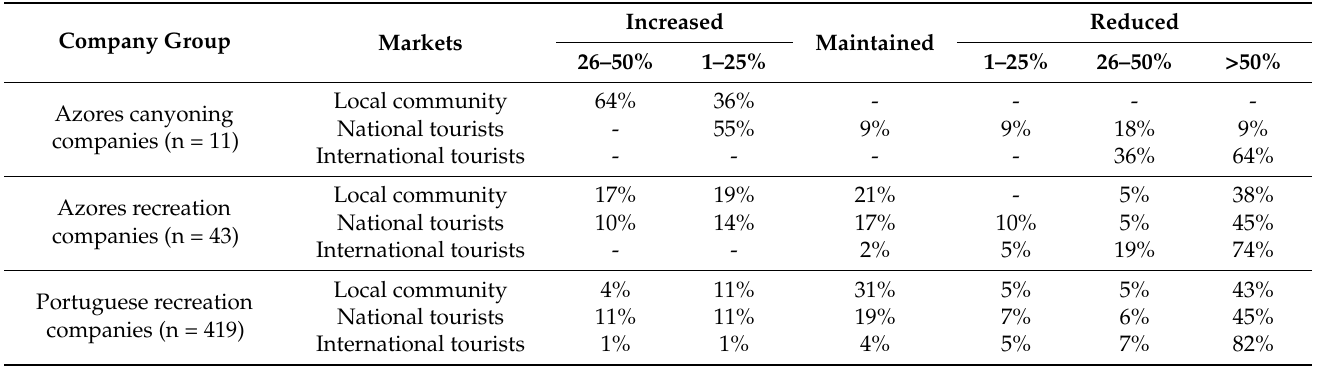
Table 3. Market variation in the third quarter of